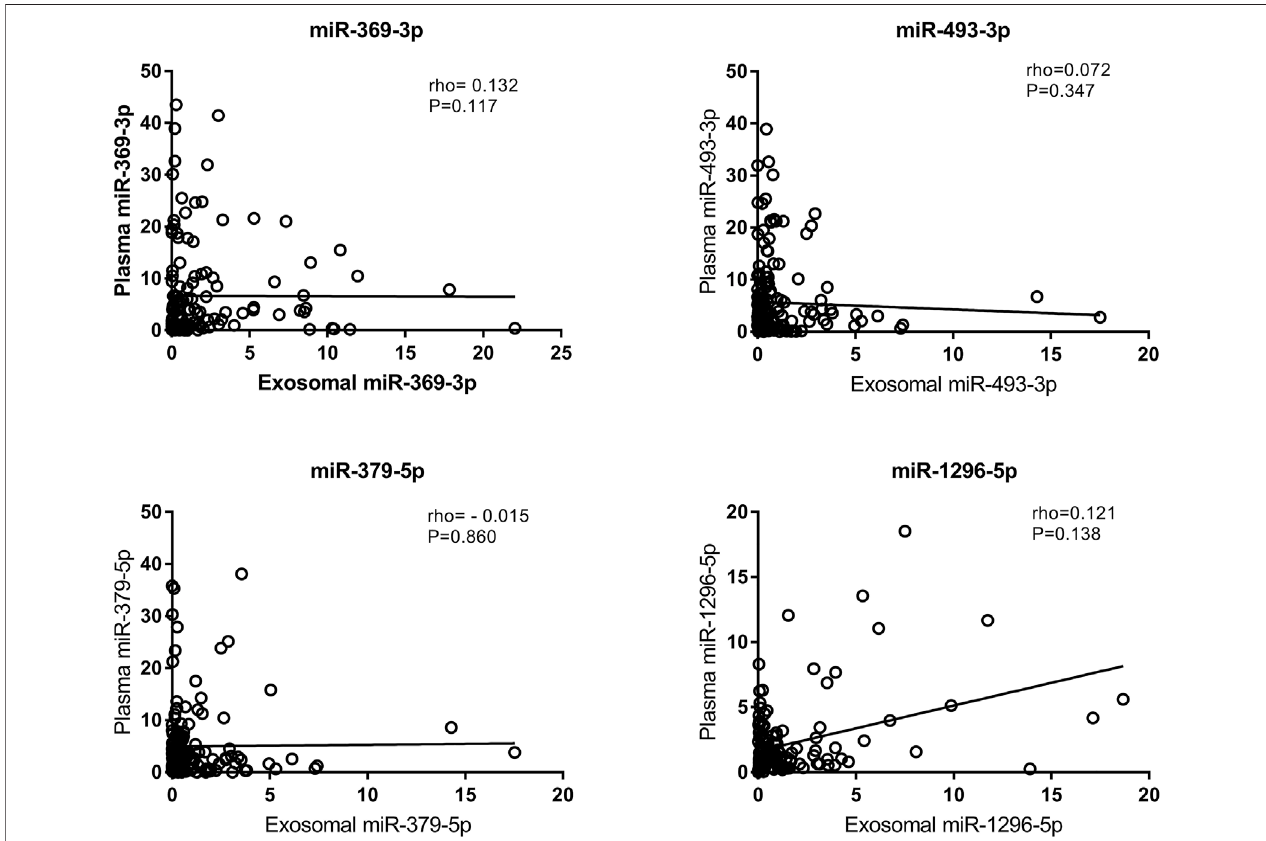
FIGURE 5 | Correlation of exosomal miRNA expression levels with plasma miRNA expression levels as assessed using Spearman ’ s correlation coef fi cient (rho).